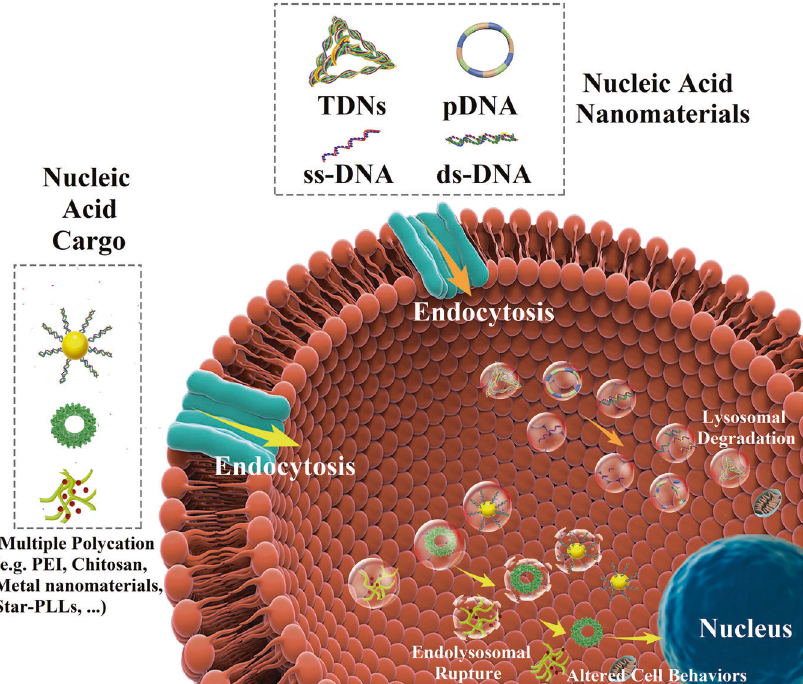
Fig. 2 The fate of DNA materials following delivery into cells. Nucleic acid nanomaterials (e.g., TDNs, pDNA, ssDNA, and dsDNA) with the excellent ability to enter cells, can be internalized by cells and degraded by lysosomal. Nucleic acid cargos combine the DNA materials and different delivery systems. These vectors can protect the DNA materials from degradation and promote cellular internalization. When inside the cells, these vector-DNA material complexes are embedded in an endosome, and these vectors can help DNA materials to escape lysosomal